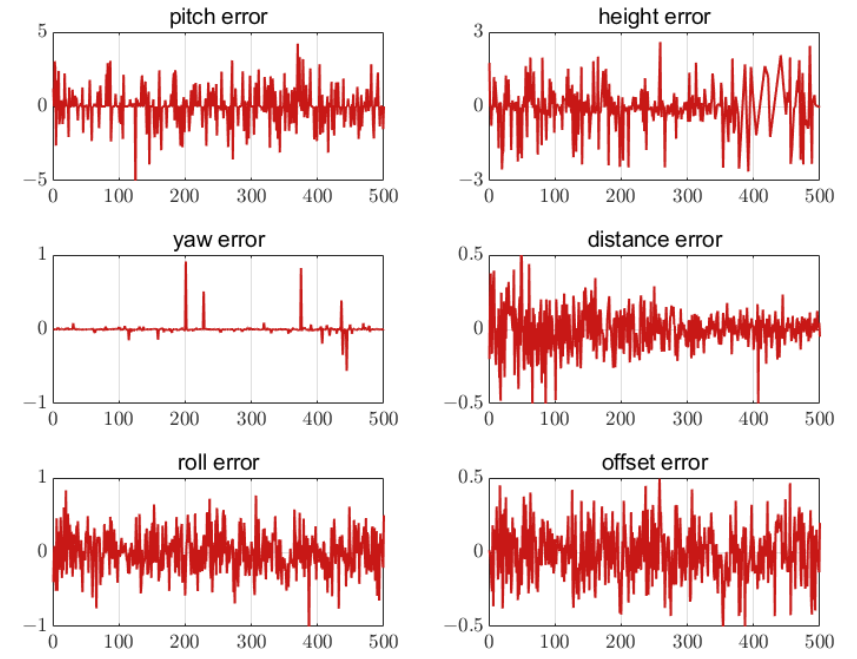
Figure 21. Error of nine feature points. The unit of the attitude error is degree. The unit of the position error is meter. The horizontal axis in all figures is the number of measurement